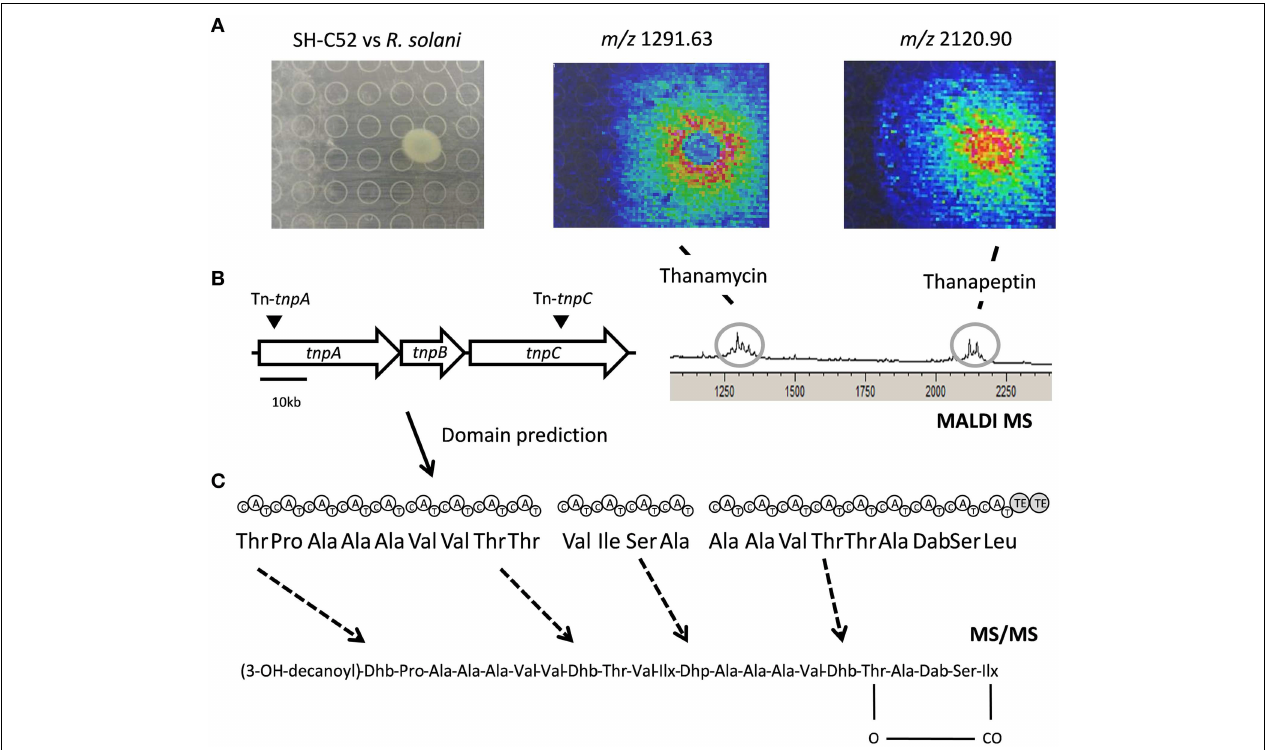
for the amino acids assembled. On the middle left, the partial spectrometry profile of the MALDI IMS of the SH-C52 and R. solani interaction is shown. (C) At the bottom the tentative thanapeptin structure obtained from tandem mass spectrometry data is presented. Dashed arrows indicate amino acids that are difficult to predict from genome information, and that needed to be resolved by mass